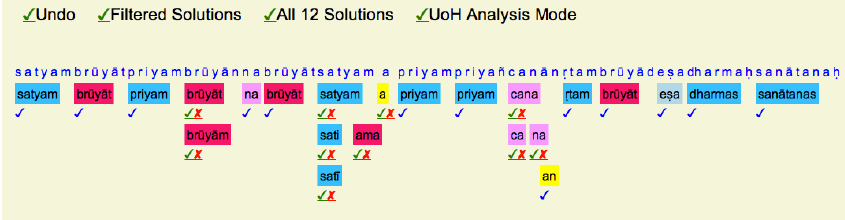
Figure 2: Aligned segments after selection of segment